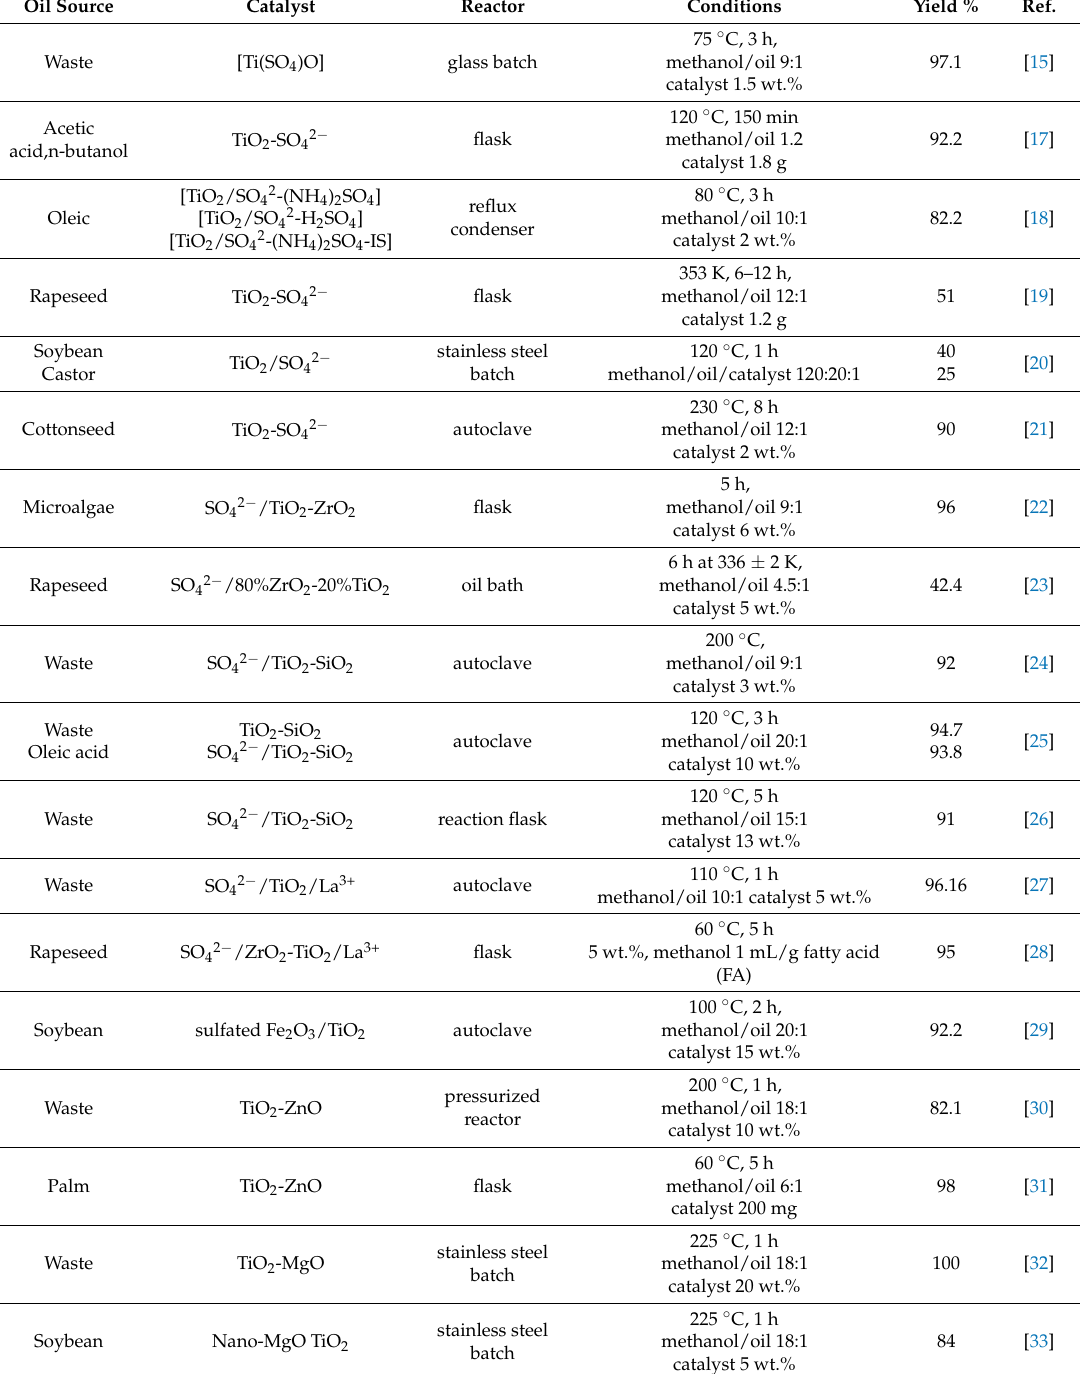
Table 13 summarized the data previously reported. Table 13. Use of titanium dioxide as catalyst in batch production of